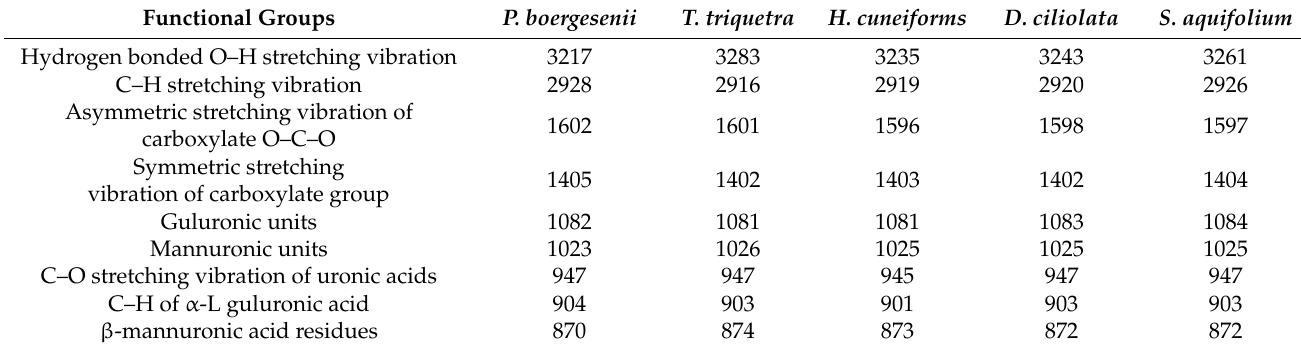
Table 3. FTIR frequency peak (cm − 1 ) and functional groups of the extracted sodium alginate. Functional